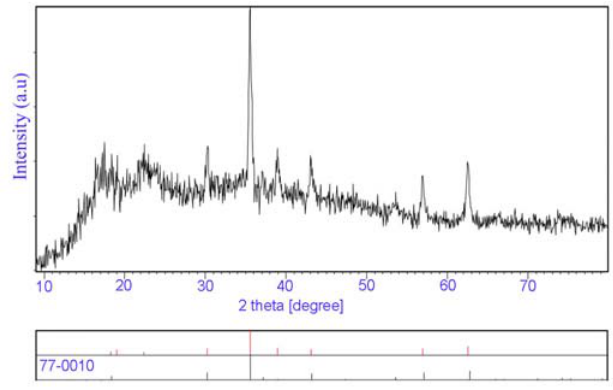
Fig. 4. XRD pattern of starch/CuFe